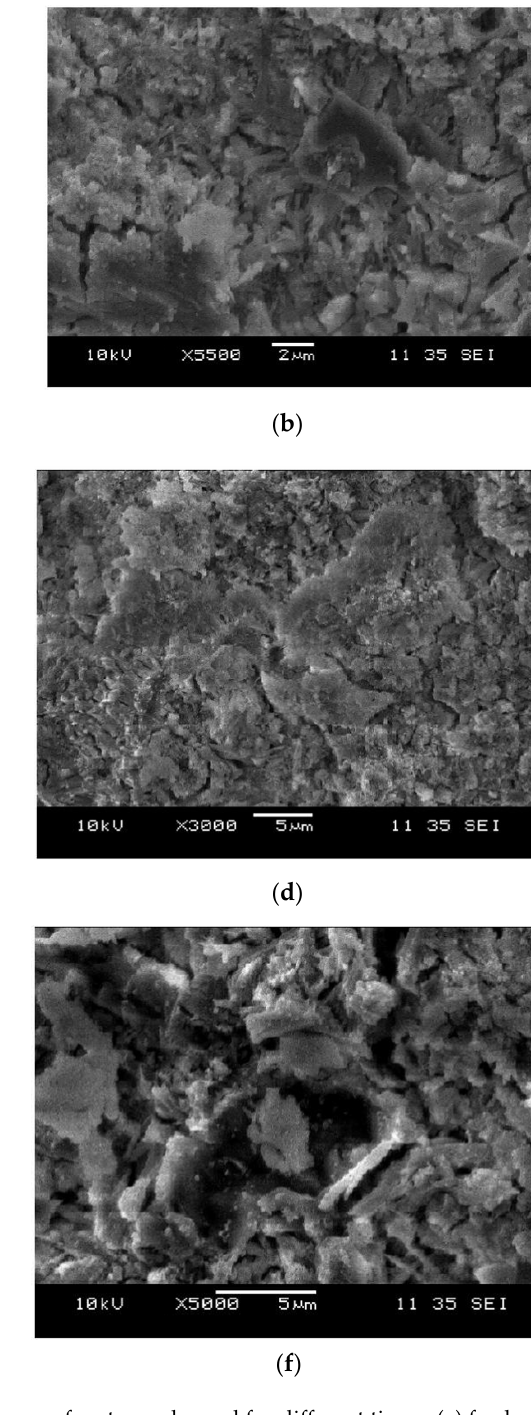
Figure 11. SEM diagrams of CSA cement mixed with different types of water and cured for different times: ( a ) freshwater cured for 1 d, ( b ) freshwater cured for 7 d, ( c ) 1SW cured for 1 d, ( d ) 1SW cured for 7 d, ( e ) 5SW cured for 1 d and ( f ) 5SW cured for 7 d.